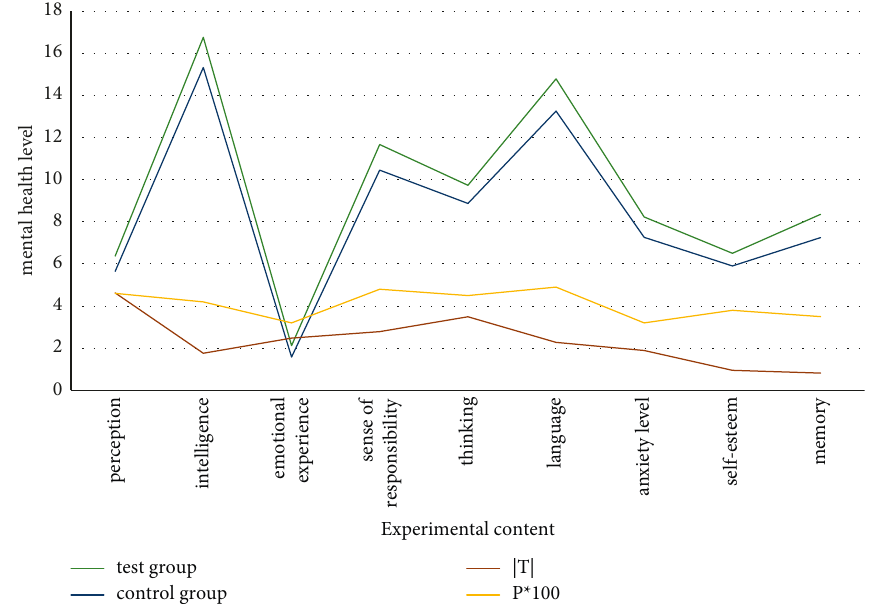
Figure 8: Statistical table of children’s mental health in experimental group and control group